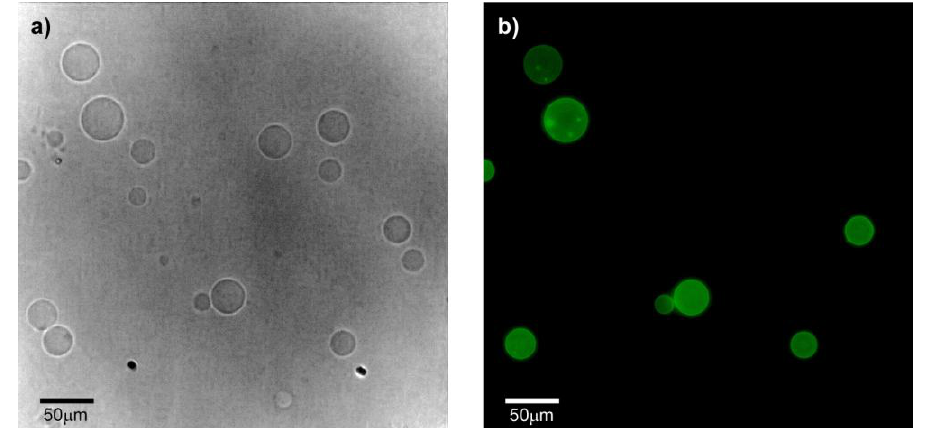
Figure 9. Microscopy images of a mixture of GUVs of DOPC-BODIPY and DOPC/DOPG (3:1) observed by ( a ) phase contrast microscopy and ( b ) upon excitation with Vis-light (both images correspond to the same